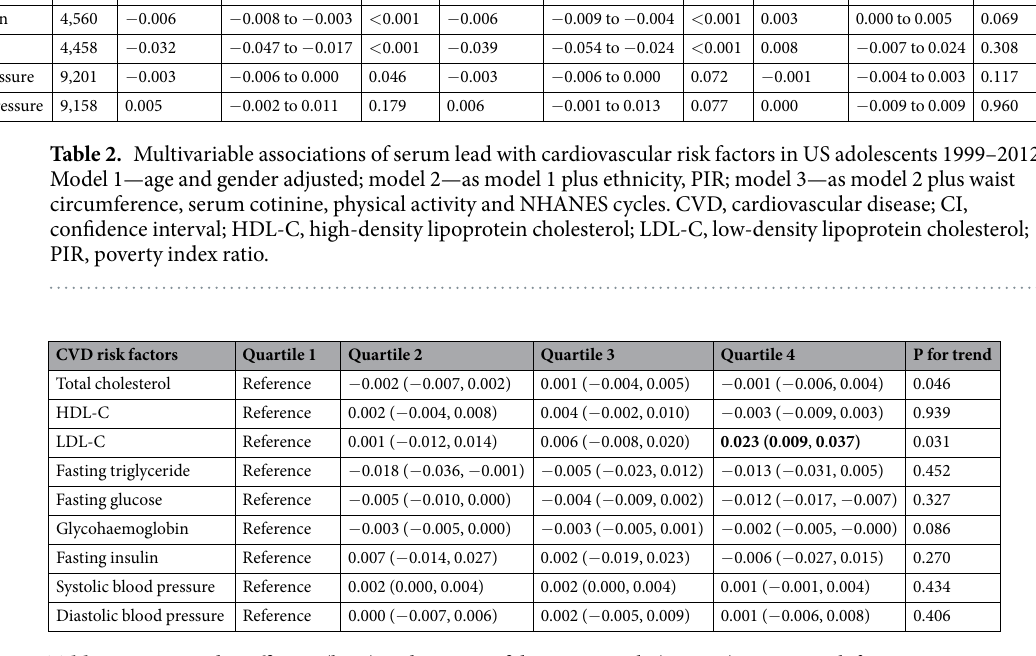
Table 3. Estimated coefficient (beta) and 95% Confidence Intervals (95% CI) in CVD risk factors in US adolescents 1999–2012 for each quartile increase in blood lead levels. Model was adjusted as age, gender, ethnicity, PIR, BMI, serum cotinine, and physical activity. CVD, cardiovascular disease; HDL-C, high-density lipoprotein cholesterol; LDL-C, low-density lipoprotein cholesterol; PIR, poverty index ratio. Lead( μ